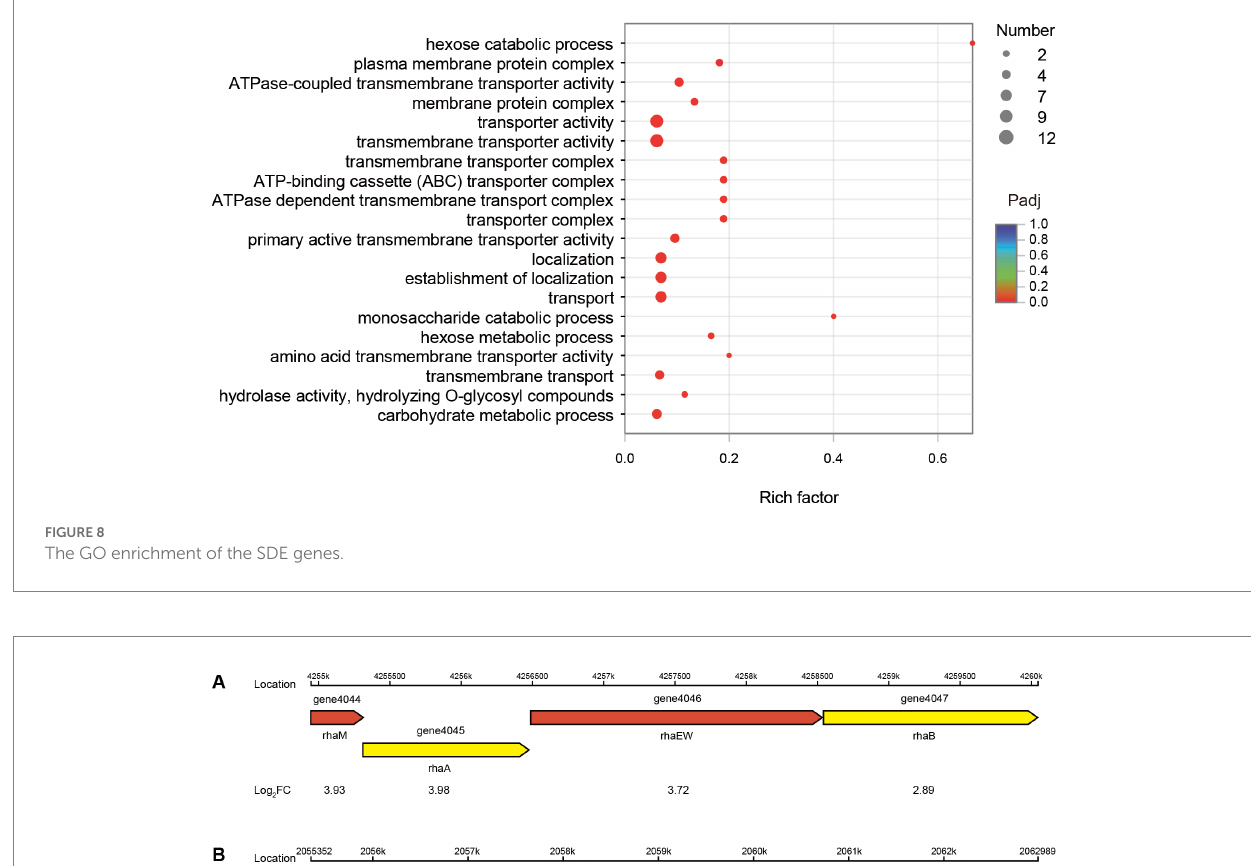
FIGURE 9 Putative genetic organization of the rha operons. (A) Rhamnose-degrading operon 1 and (B) rhamnose-degrading operon